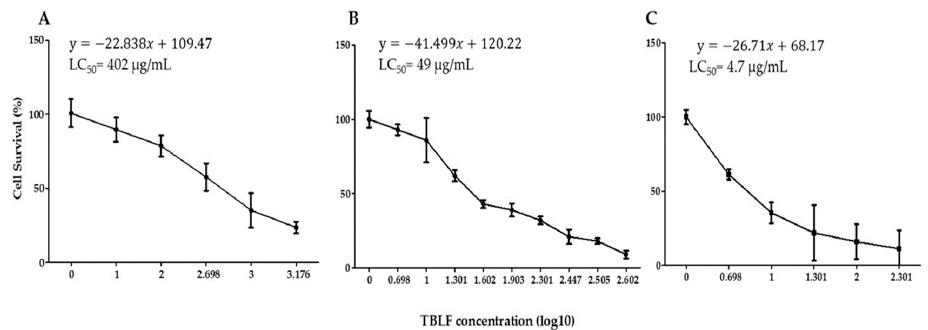
Figure 1. Concentration–response curves for HT-29, RKO and SW-480 cells. Cells were treated with different concentrations of Tepary bean lectin fraction (TBLF) for 24 h. ( A ) HT-29 cells (1, 10, 100, 500, 1000 and 1500 µ g / mL). ( B ) RKO cells (1, 5, 10, 20, 40, 80, 200, 280, 320 and 400 µ g / mL). ( C ) SW-480 cells (1, 5, 10, 20, 100 and 200 µ g / mL). A linear regression of log10 of the TBLF concentration vs. cell survival (%) was calculated in each